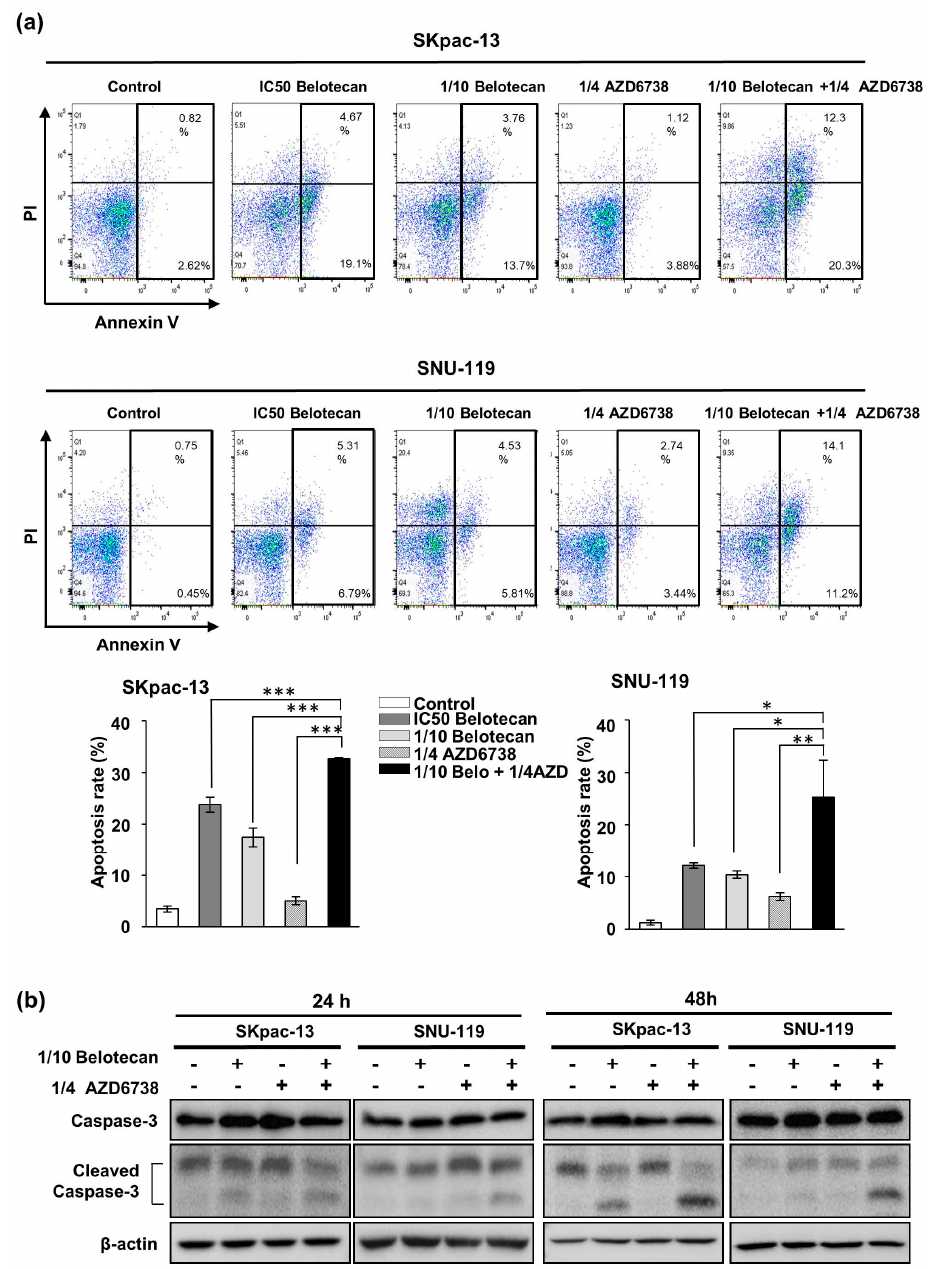
Figure 2. Synergistic effect of belotecan and AZD6738 on apoptosis. ( a ) Apoptosis assay demonstrated the synergistic effect of AZD6738 (1/4 IC 50 ) combined with belotecan (1/10 IC 50 ) in both SKpac-13 and SNU-119 cells. Data are presented as the mean ± standard deviation of triplicate experiments p -values were calculated by a student t -test, indicating * p < 0.05, ** p < 0.01, and *** p < 0.001. ( b ) Western blot showed that apoptosis marker, cleaved caspase-3, increased with the combination of both drugs, and beta actin was used as a loading